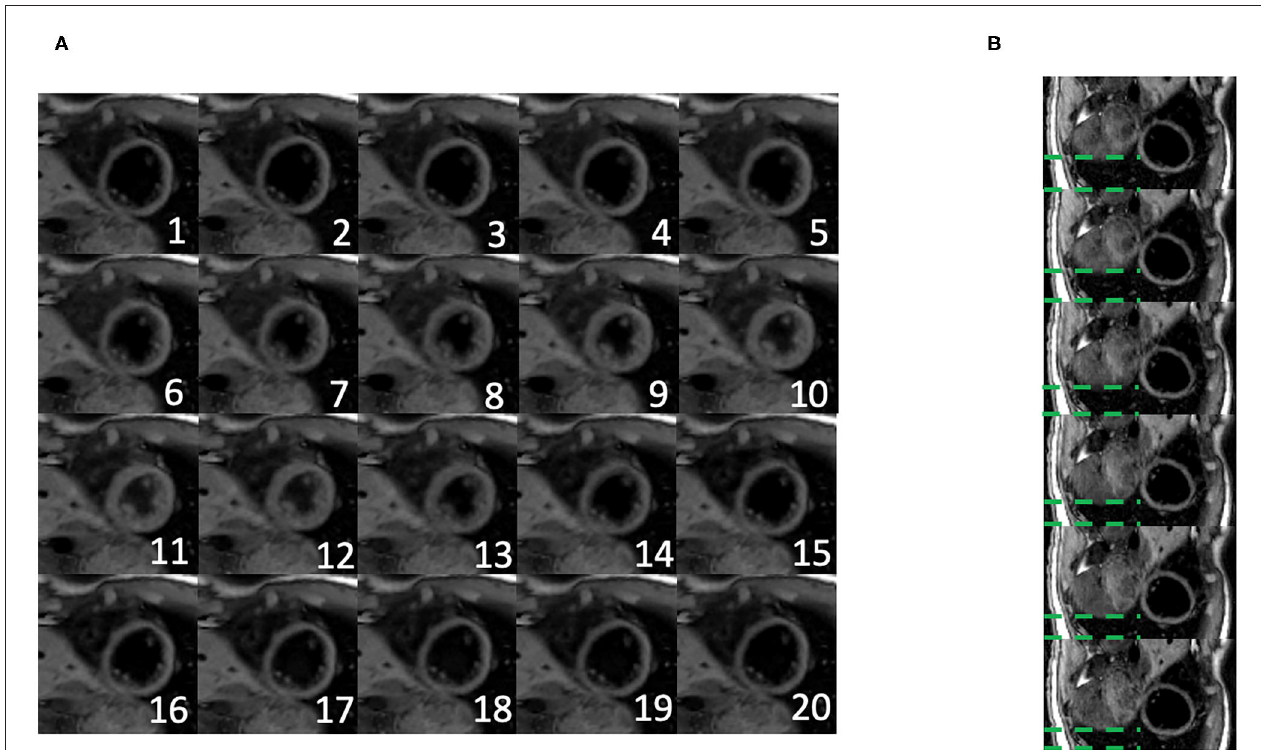
FIGURE 5 | (A) Twenty cardiac phases are generated after the binning procedure. (B) Six respiratory phases are generated after the binning, the displayed images show the exhalation process. The green dash line represents the distance between the liver dome and the bottom of the image. The liver dome position approaches the bottom of the image during